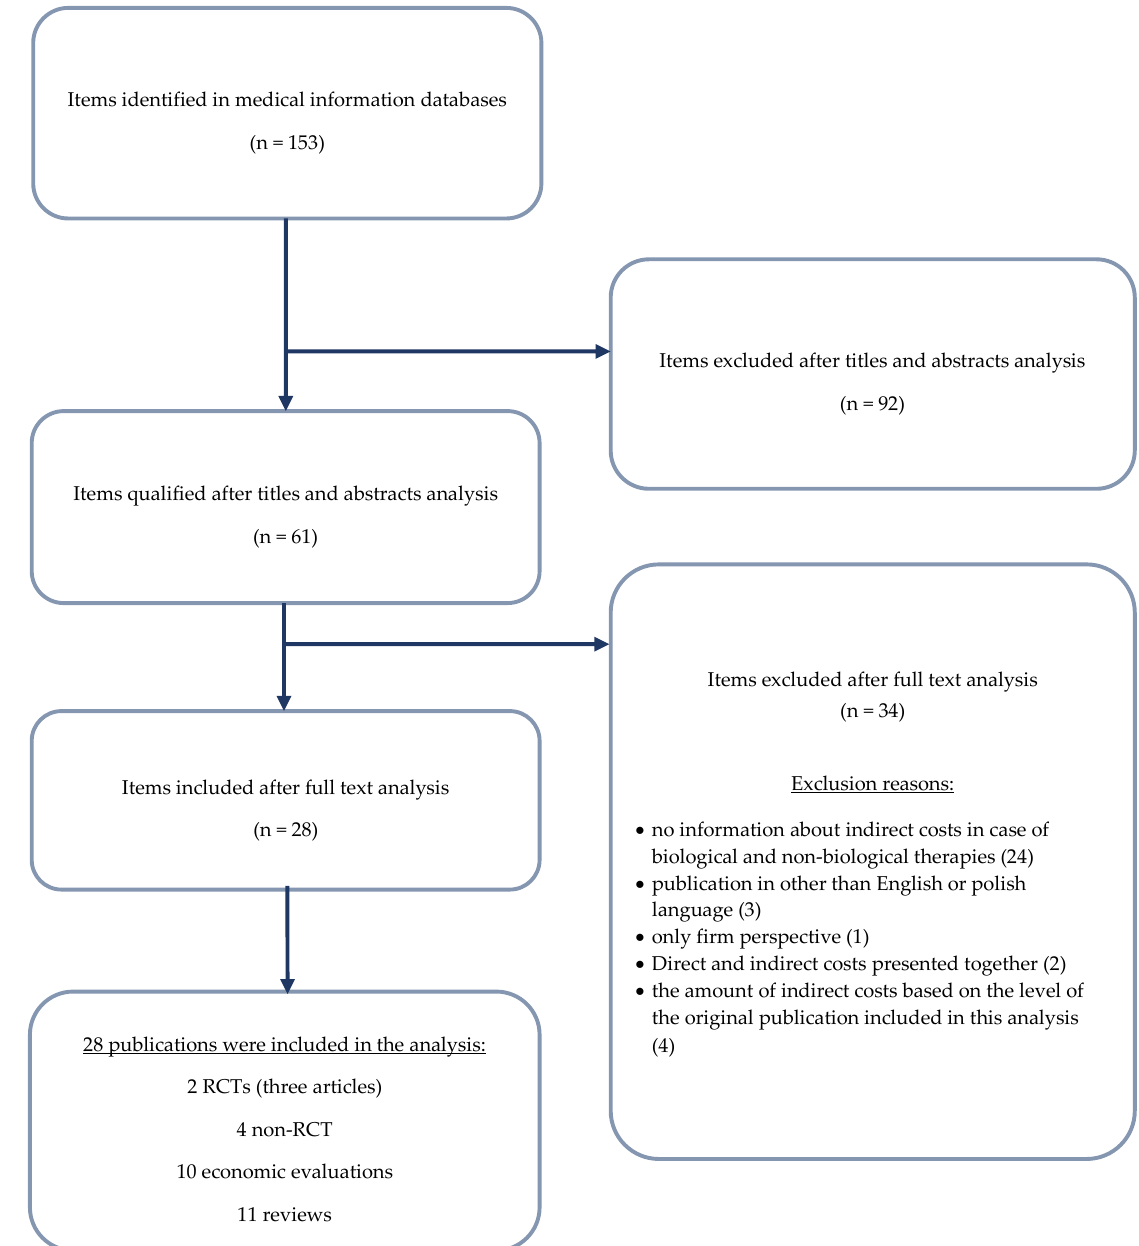
Figure1. Figure 1. Scheme of selection of clinical trials found in the systematic review in accordance with PRISMA.